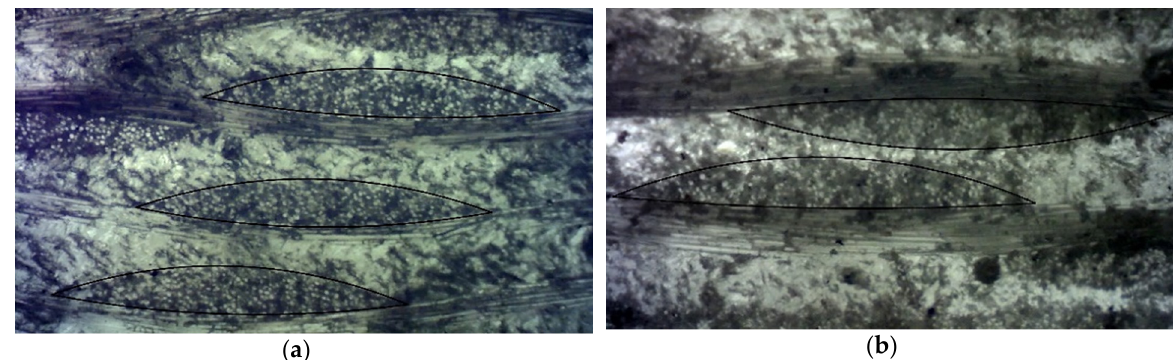
Figure 5. Microphotographs of filaments in the structure of fiberglass plastics with magnification 1:40: ( a ) T-23; ( b ) EZ-200.